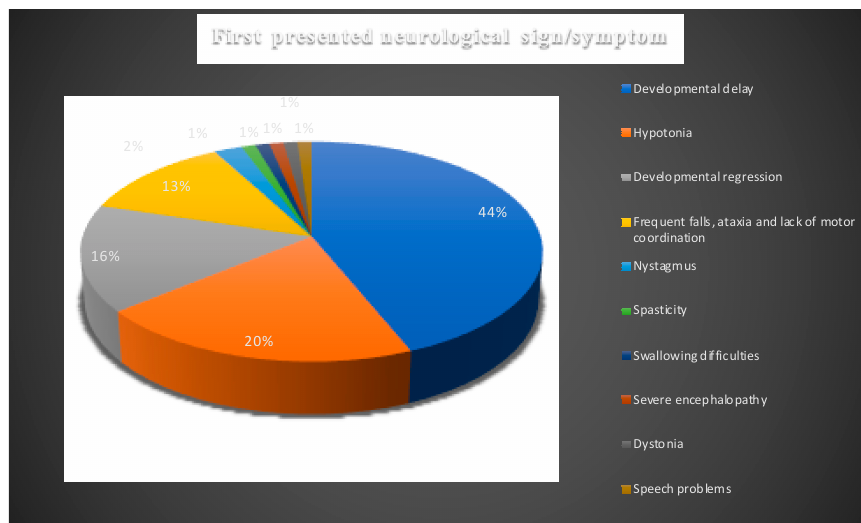
Figure 3. Presenting neurological signs and symptoms of all NPC1 patients. Blue: developmental delay; orange: hypotonia; silver: developmental regression; yellow: frequent falls, ataxia, and lack of motor coordination; light blue: nystagmus; green: spasticity; navy blue: swallowing difficulties; orange-red: severe encephalopathy; grey: dystonia; mustard: speech problems.